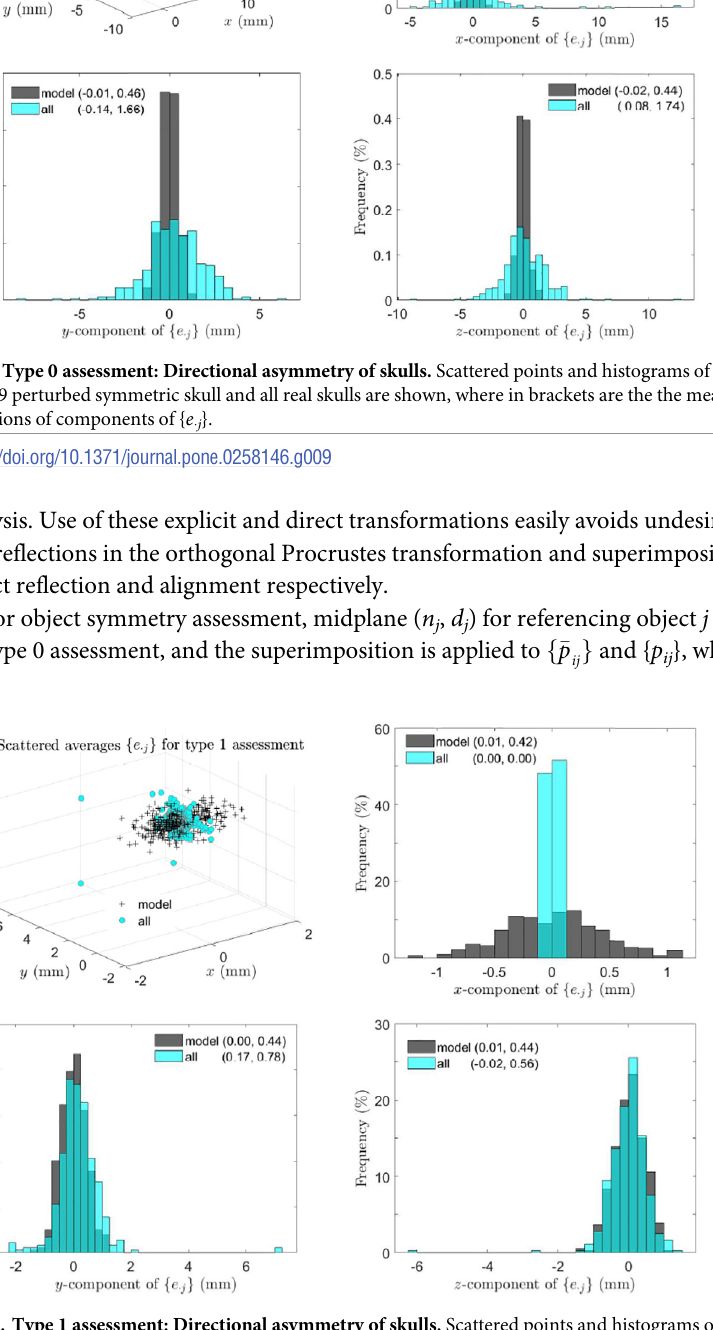
Fig 10. Type 1 assessment: Directional asymmetry of skulls. Scattered points and histograms of asymmetry indices of the 359 perturbed symmetric skull and all real skulls are shown, where in brackets are the the means and standard deviations of components of { e � j